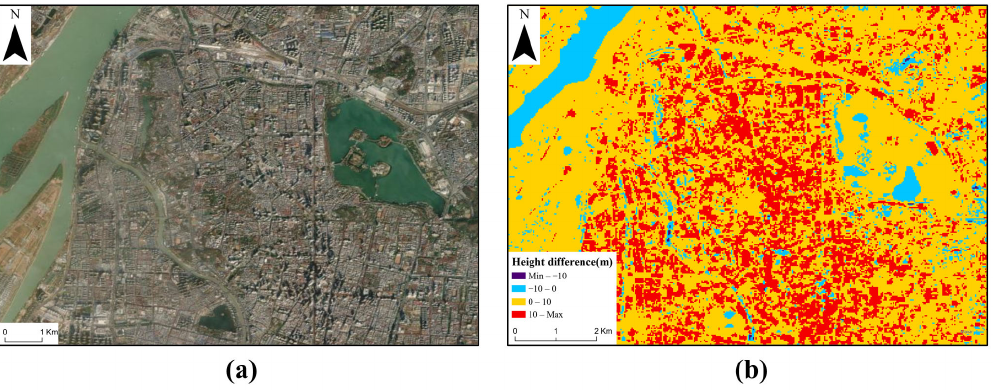
Figure 5. ( a ) RS image, ( b ) Result of AW3D30 minus